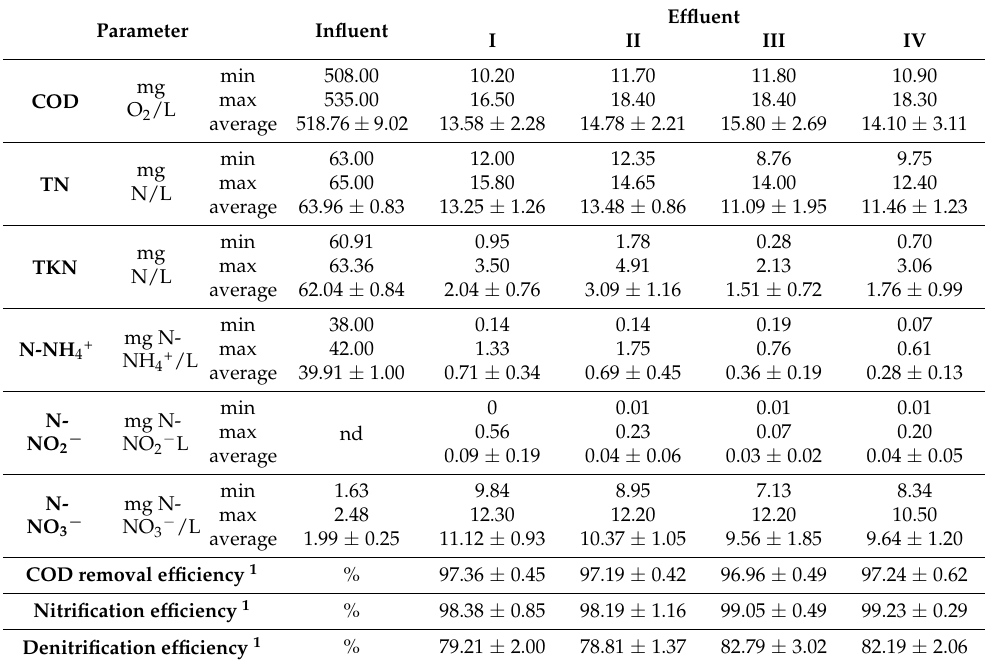
Table 2. Influent and effluent